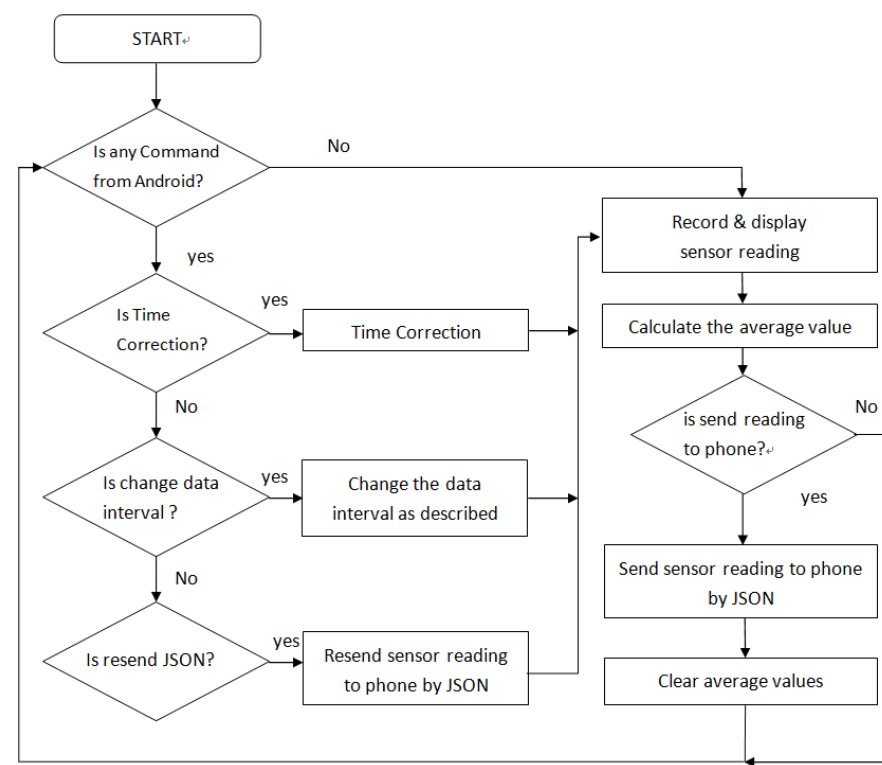
Figure 8. Flow chart of the